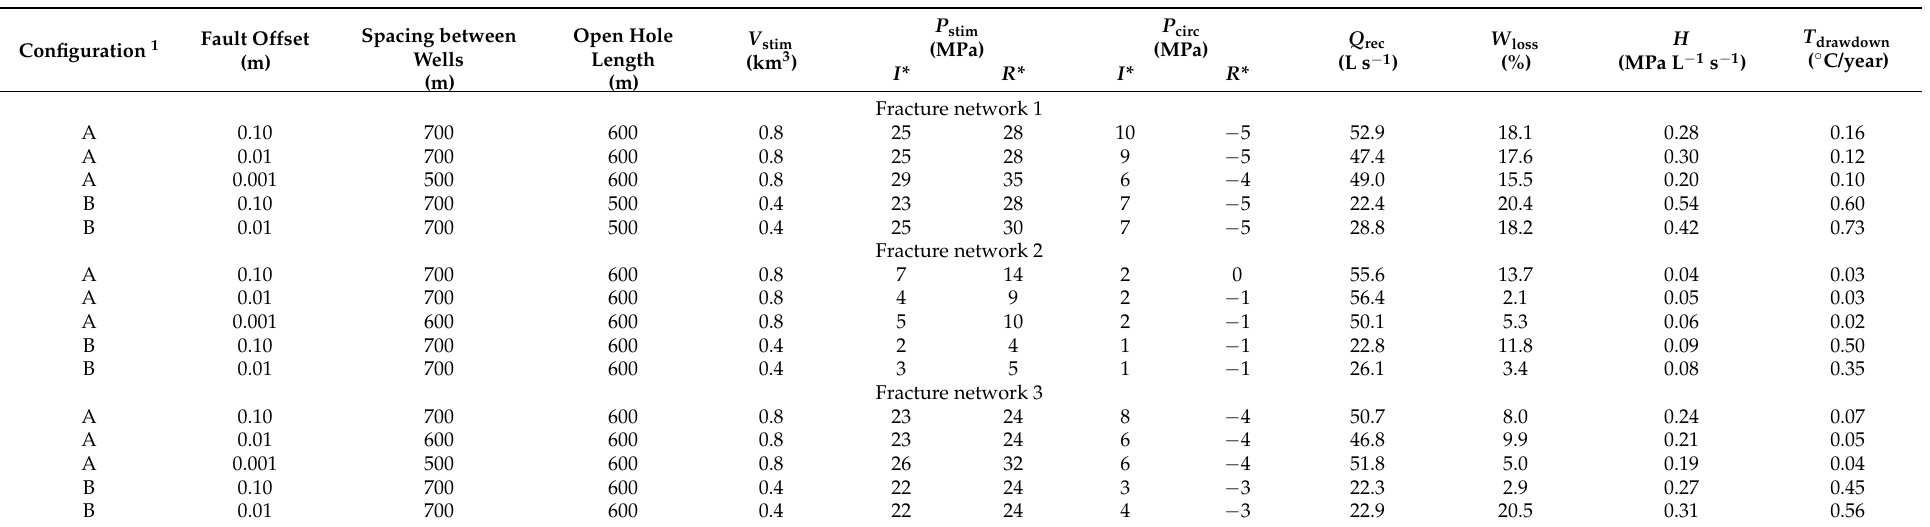
Table 4. Design parameters and results.